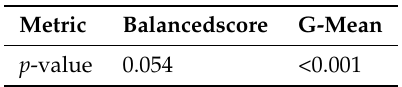
Table 16. p -Value of Friedman test for